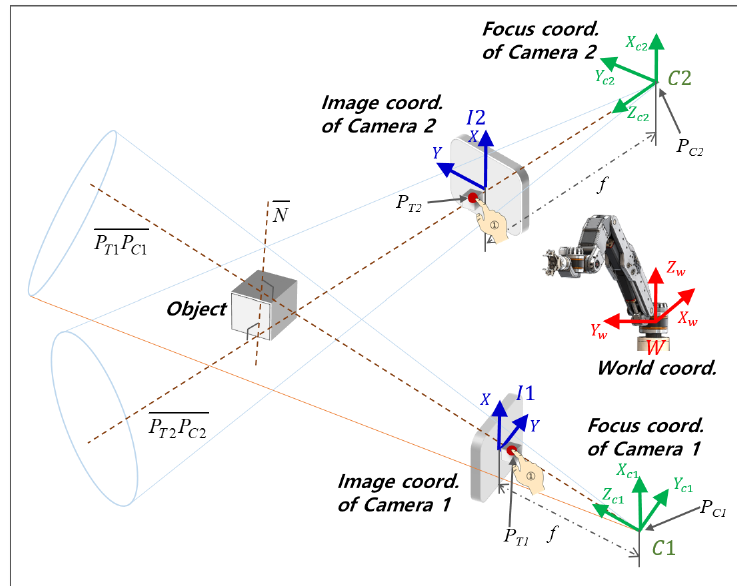
Figure 5. Translation estimation of object.